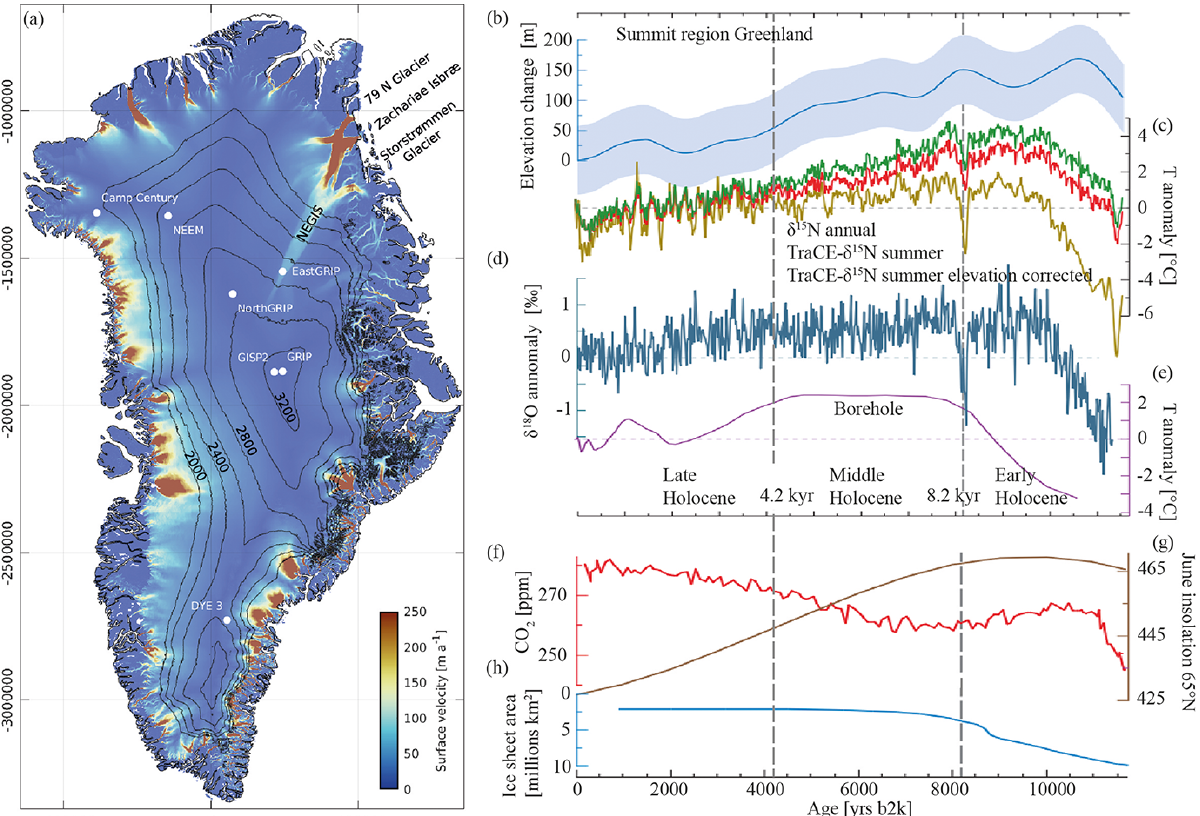
Figure 2. (a) Overview map of Greenland, including relevant ice core drill sites and surface velocities from Gerber et al. (2021). (b) Estimated surface elevation change at Summit (dark blue, Vinther et al., 2009) and uncertainty (faded blue shading, Lecavalier et al., 2013). (c) Annual δ 15 N (dark yellow) and summer (red) and elevation-corrected summer (green) Summit temperature anomalies from TraCE- δ 15 N (Buizert et al., 2018). (d) GRIP oxygen isotopes (Rasmussen et al., 2006; Vinther et al., 2006). (e) GRIP borehole temperature reconstruction